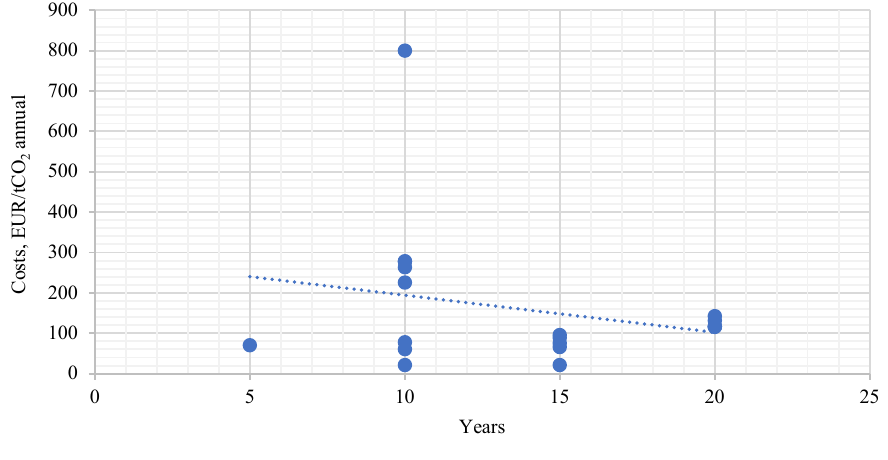
Fig. 4. Relationships between CCFI competition group average costs of one CO 2 tonne reduction to projects lifetime. As shown in Fig. 4, most of the projects with the same lifetime have very different costs for one CO 2 tonne reduction. The differences are in range from 21.4 EUR/tCO 2 per year to 800 EUR/tCO 2 per year. Comparing the minimal (5 years) and maximal (20 years) projects lifetime, CO 2 reduction costs are on the average level, 70.7 (5 years’ projects lifetime) and about 129 EUR/tCO 2